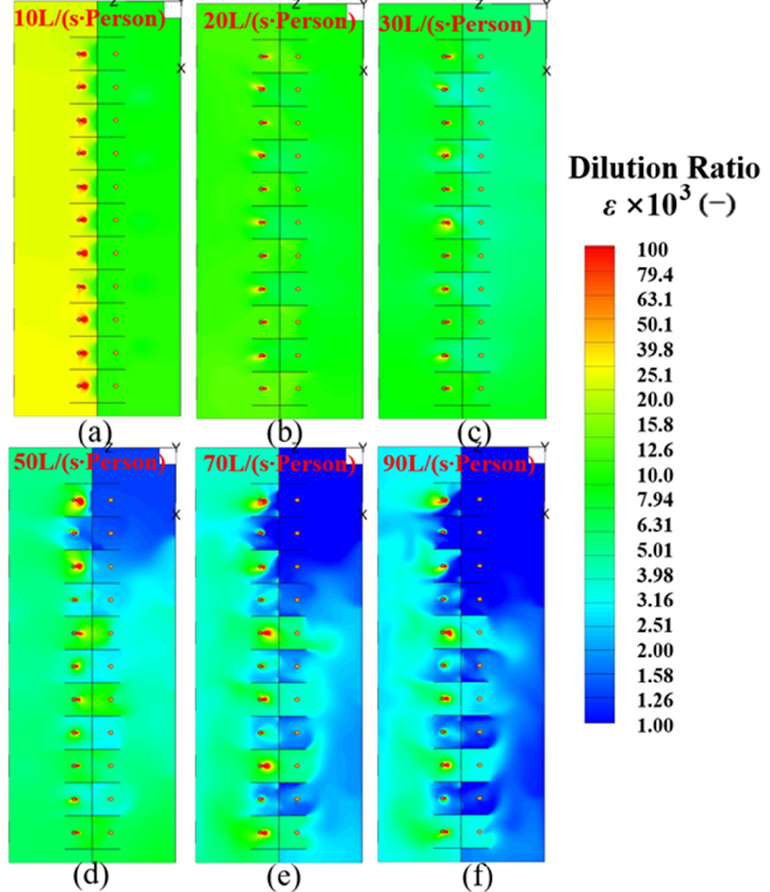
Figure 12. Dilution ratio distribution at the breathing height (y = 1.1 m) under the SEFV with different ventilation rates: ( a ) 10 L/(s · Person); ( b ) 20 L/(s · Person); ( c ) 30 L/(s · Person); ( d ) 50 L/(s · Person); ( e ) 70 L/(s · Person); ( f ) 90 L/(s · Person). Increasing ventilation rate may raise the risk of exposure under specified